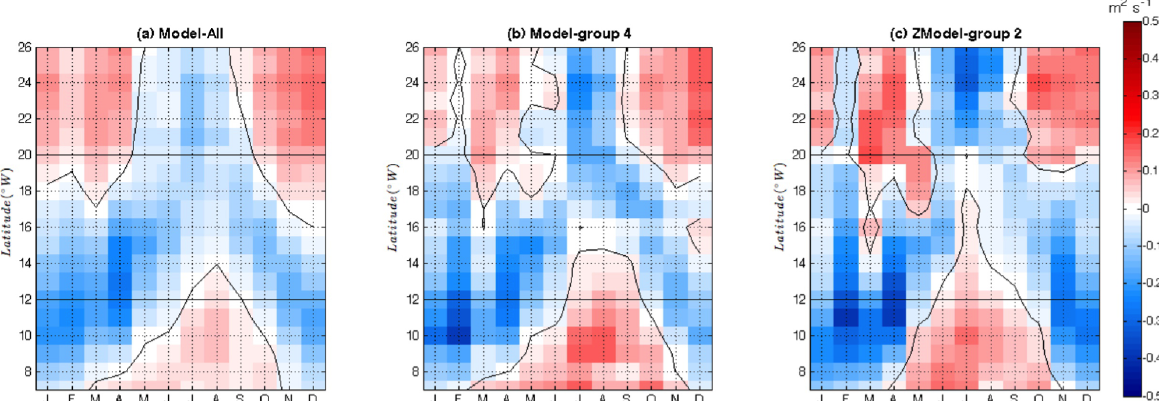
Figure 13. Latitude–time diagram of the seasonal shift of the meridional component of the wind stress with respect to the present day. For each month and at each latitude, we show the meridional wind stress shift with respect to the present day averaged over the period 2080– 2100. Positive values (red) mean that the wind stress shift is southward and is thus favorable to upwelling. Panel (a) stands for Model-All, (b) Model-group 4 and (c) ZModel-group